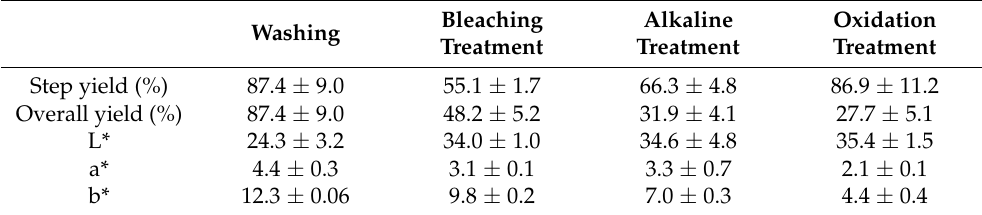
Table 1. Yield and color of corn stover sample after each step of